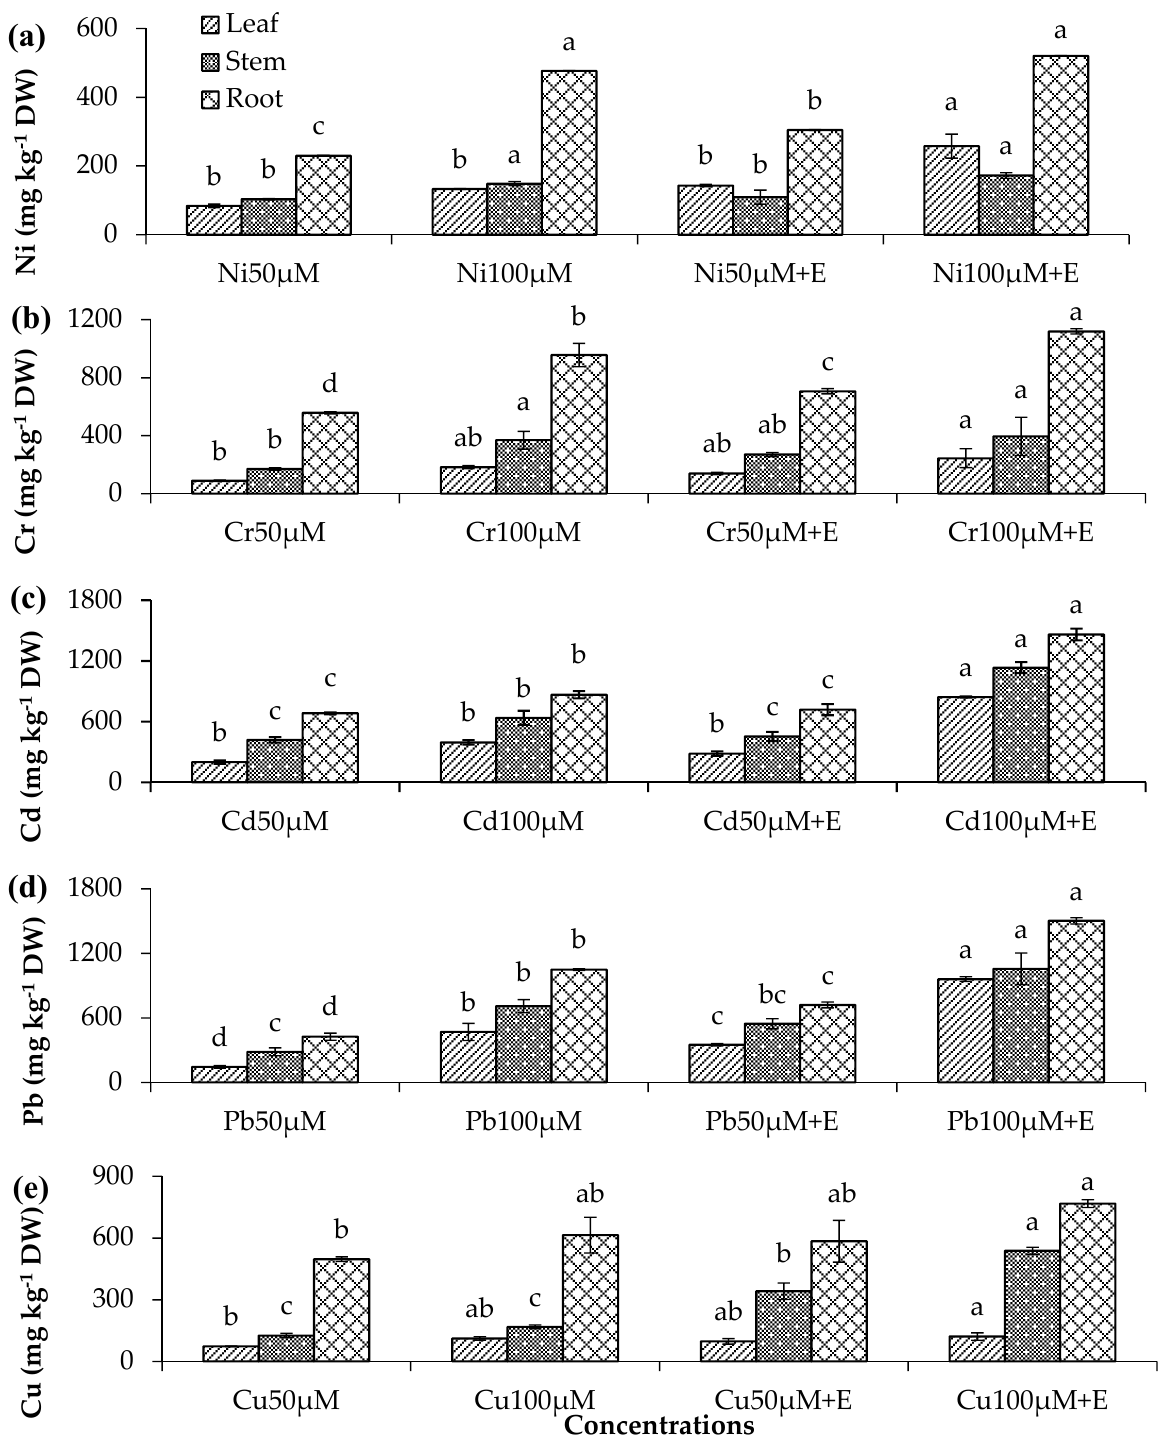
Figure 1. Metal accumulation in the leaves, stems, and roots of Catharanthus roseus , Ni ( a ), Cr ( b ), Cd ( c ), Pb ( d ) and Cu ( e ). Exposure at 50 µM and 100 µM MCs without and with 2.5 mM EDTA (E). According to the Duncan test, different letters above the bars denote significant difference at the significance level p < 0.05, with “a” being the significantly highest uptake followed by the other alphabets for respective plant compartment. Each bar is a mean of three replicates ± SE. Table 4. Cumulative metal uptake in µg per plant compartment at the time of harvest.